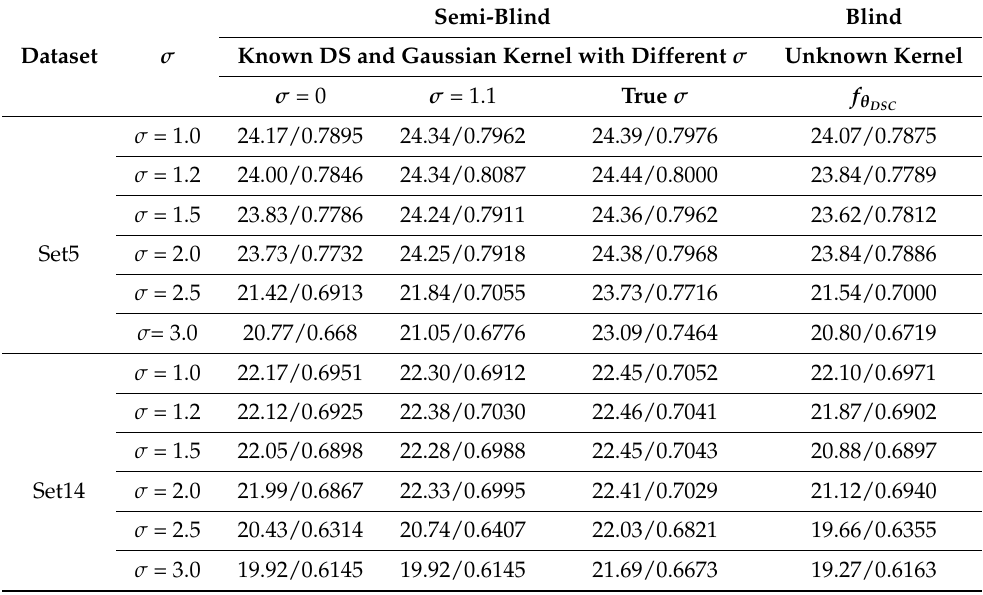
Table 2. Quantitative comparison for super-resolving the LR images with Gaussian blur kernels (different standard deviation values) and the bicubic down-sampling (DS) operation. The first and second numerals represent the PSNR and SSIM values,